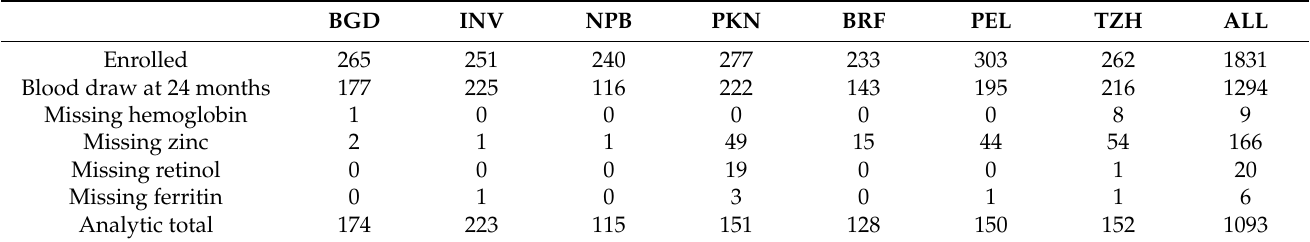
Table 1. Cohort profile by site. BGD, Bangladesh; INV, India; NPB, Nepal; PKN, Pakistan; BRF, Brazil; PEL, Peru; TZH, Tanzania.